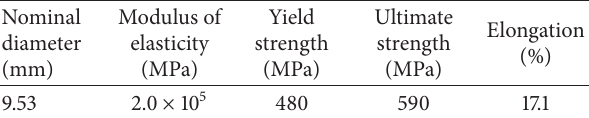
Table 2: Mechanical properties of rebar